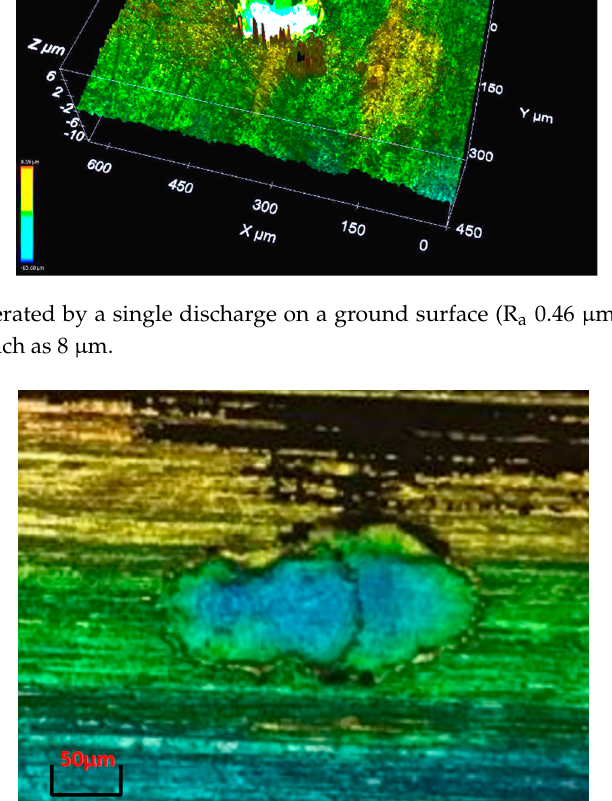
Figure 3. Occurrence of two consecutive single craters on a ground surface.